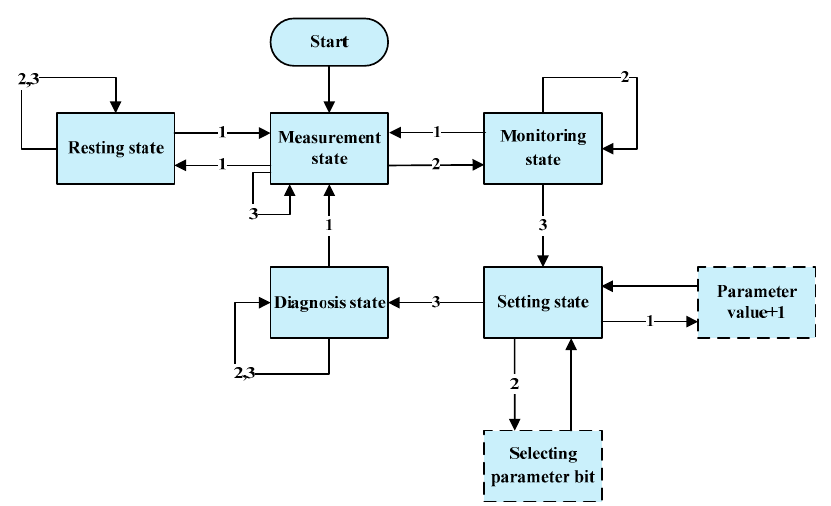
Figure 9. State machines of the processor system software.